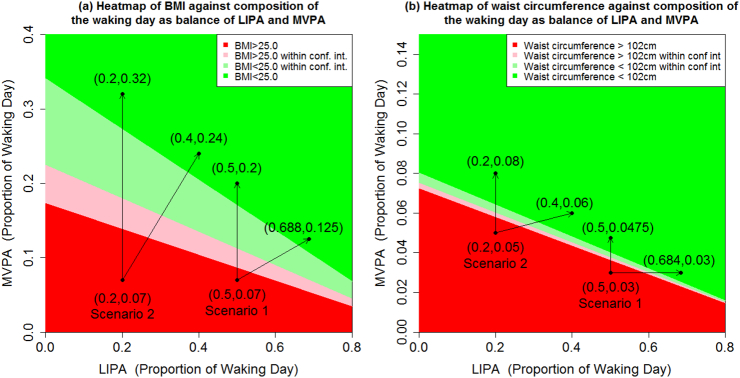
Expected (a) BMI and (b) waist circumference against composition of the waking day according to balance of MVPA and LIPA, with the remaining proportion of the waking day made up of SB, for a white British male with degree level education, not taking heart medicine and (a) aged 40 with no history of diabetes, and living in a household where total income is over £2600pa; (b) aged 40 with no history of diabetes, and living in a household where total income is under £2600pa. The pale regions referred to as within confidence interval are combinations of LIPA and MVPA where the 95% confidence interval for the expected outcome includes the threshold, either BMI = 25.0 kg m−2 or waist circumference = 102 cm. Based on Health Survey for England 2008.